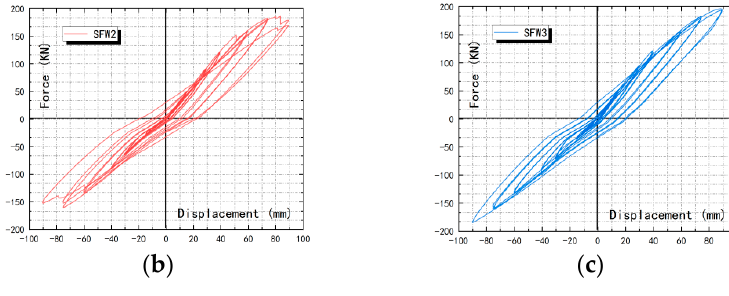
Figure 11. Hysteric curves of SFW1 ( a ), SFW2 ( b ) and SFW3 ( c ).